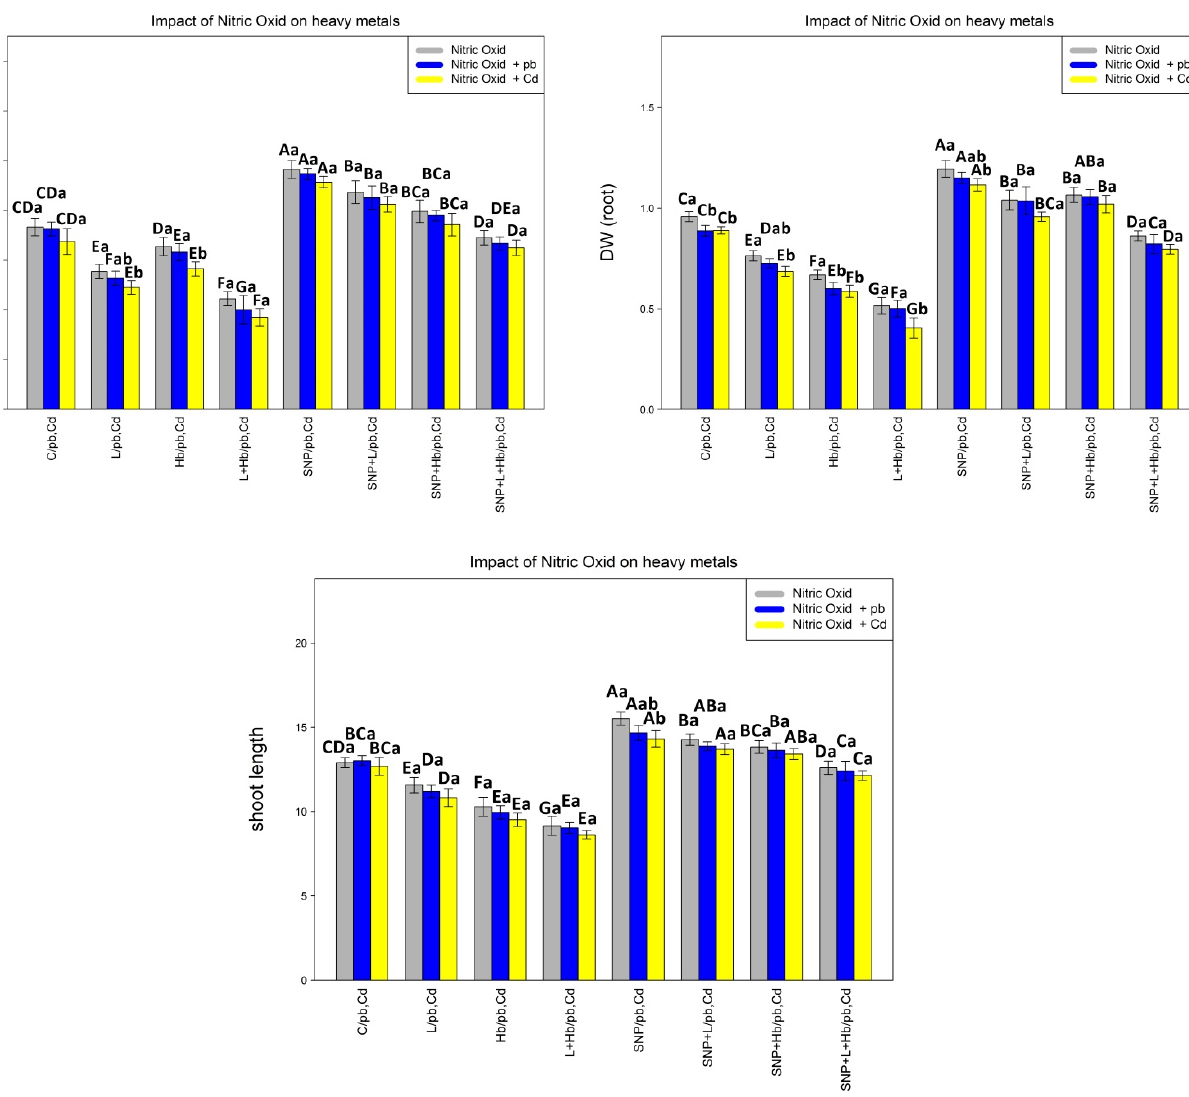
Figure 4. Effect of nitric oxide (NO) concentrations on bamboo biomass (DW shoot and DW root) and shoot length of A. pygmaea L. with 200 µ M Pb and 200 µ M Cd. The treatments contained various concentrations of nitric oxide alone or in combination with 200 µ M Pb and 200 µ M Cd. The capital letters showed statistically significant differences across various levels of nitric oxide alone or in combination with 200 µ M Pb and 200 µ M Cd (the bars with the same colors), while the lowercase letters showed statistically significant differences within each concentration of nitric oxide (NO) alone or in combination with 200 µ M Pb and 200 µ M Cd (the bars with different colors) according to Tukey’s test ( p < 0.05).